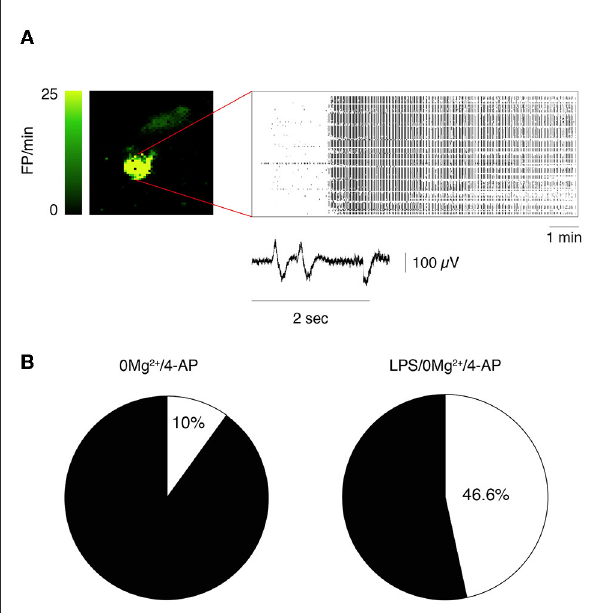
FIGURE3 Incidence of status epilepticus in LPS-treated slices. (A) Depicts a representative activity map (higher FP frequency corresponds to lighter green color) and raster plot showing a status epilepticus (SE) event in hippocampus. Enlarged tracing depicts FPs from one representative electrode. (B) Shows the incidence of SE events in 0 Mg 2 + /4-AP exposed slices ± LPS (10 µ g/ml LPS for 30min, followed by 5min washout). 0 Mg 2 + + 4-AP, n = 9 slices; LPS + 0 Mg 2 + + 4AP, n = 10 slices. p < 0.05 vs. 0 Mg 2 + /4AP by Chi-square